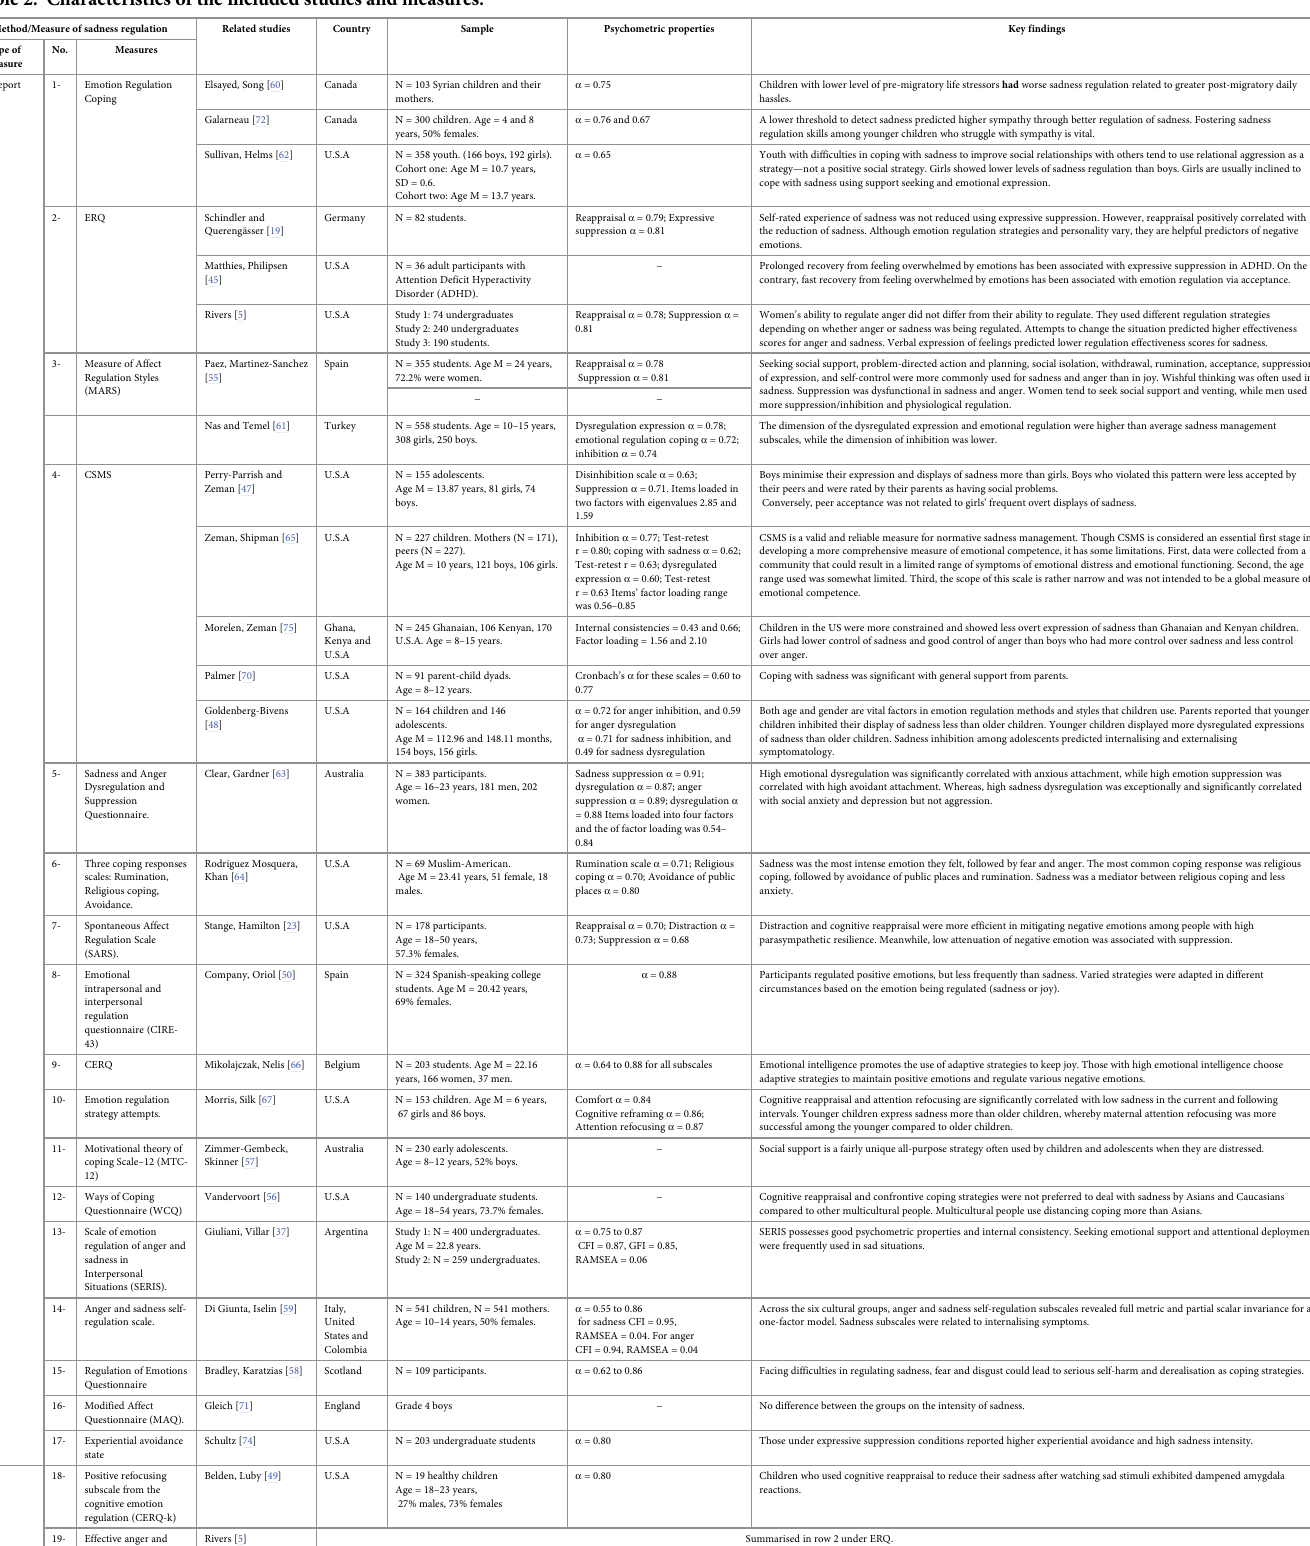
Table 2. Characteristics of the included studies and